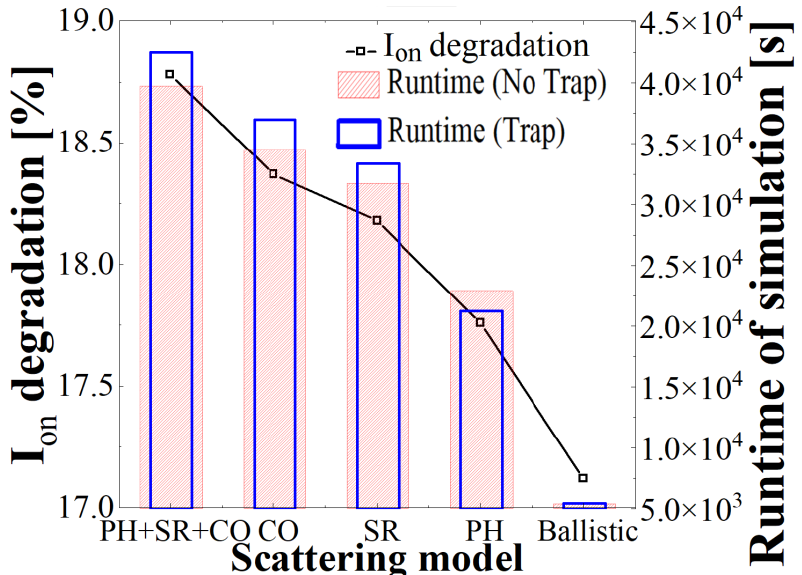
Figure 6. I on degradation owing to displacement defect and runtime of simulation with various scattering models. Various scattering models of coulomb (CO), surface roughness (SR), and phonon (PH) are compared regarding I on degradation and simulation runtime.